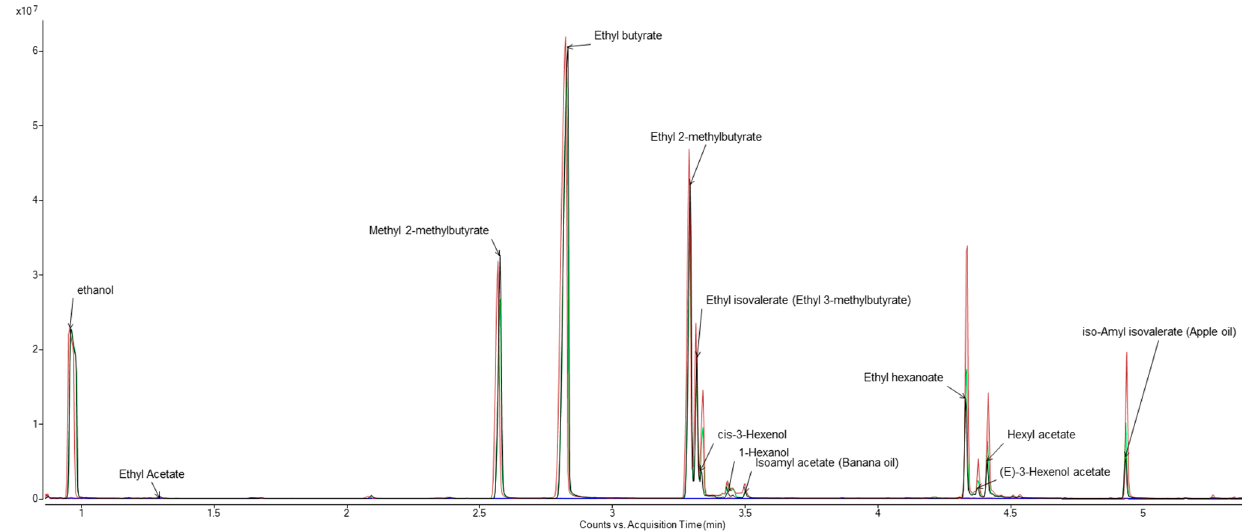
Figure 6. Aroma profile of strawberry essential oil. Total ion chromatograms of three parallel measurements (colored by black, green and red). Table 4. List of strawberry aroma’s compounds.